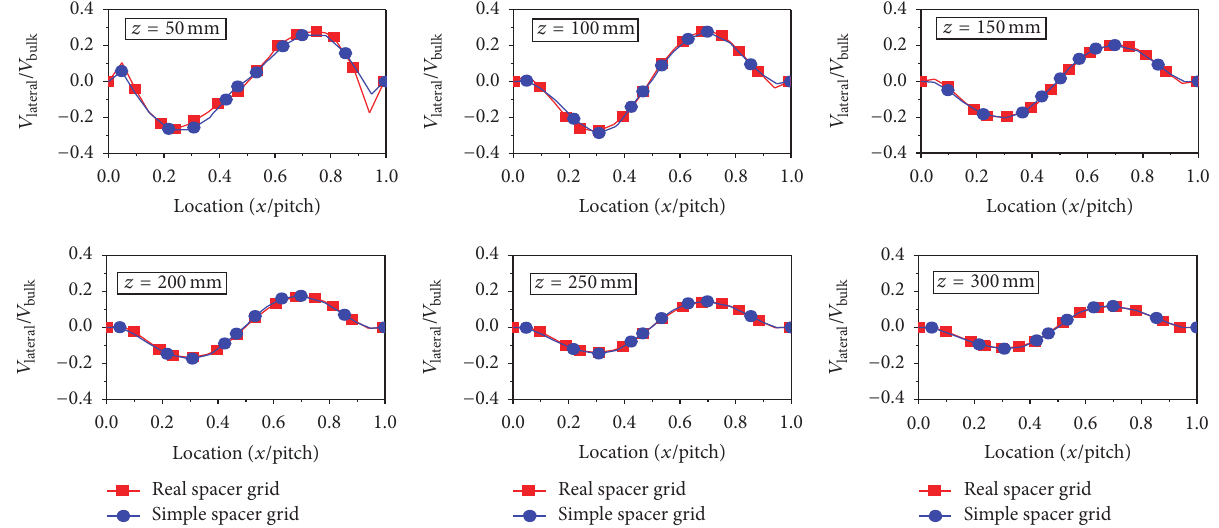
Figure 28: Comparison of the lateral flows between two kinds of grids.